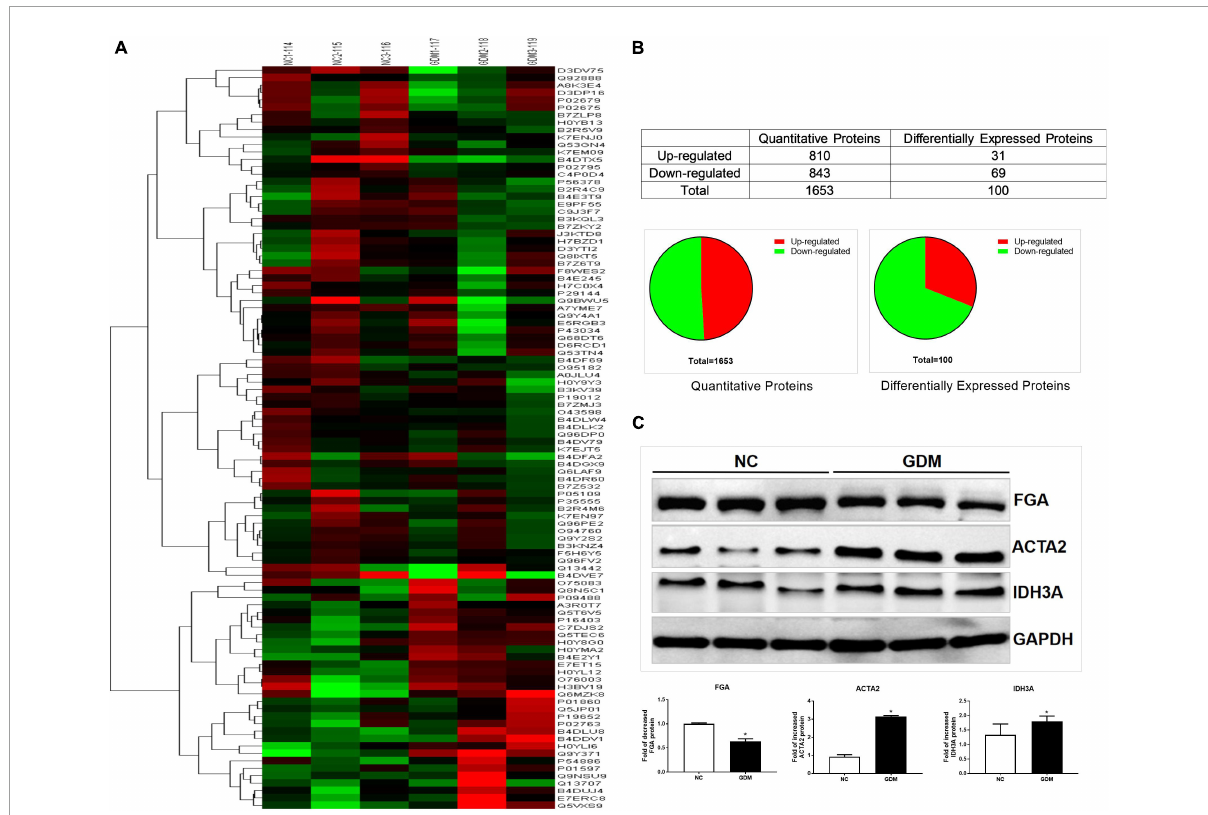
FIGURE1 iTRAQ analysis results for the GDM umbilical vessels. (A) Hierarchical clustering of DEPs. (B) The statistic of the proteins identified in umbilical vessels. (C) Validation of the differential expression of the selected proteins in umbilical vessels by western blotting: FGA, ACTA2, IDH3A. Data are presented as mean ± SE ( n = 3). * p <